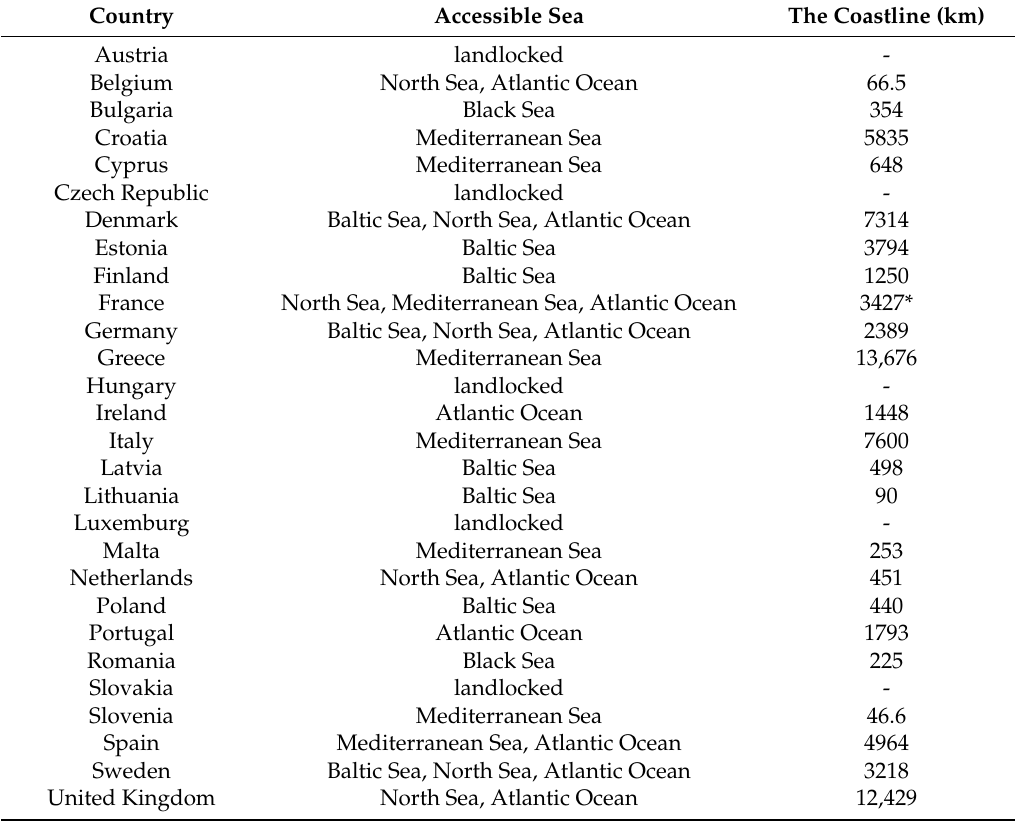
Table 1. Coastline in the European Union countries. Source: own study based on [40].